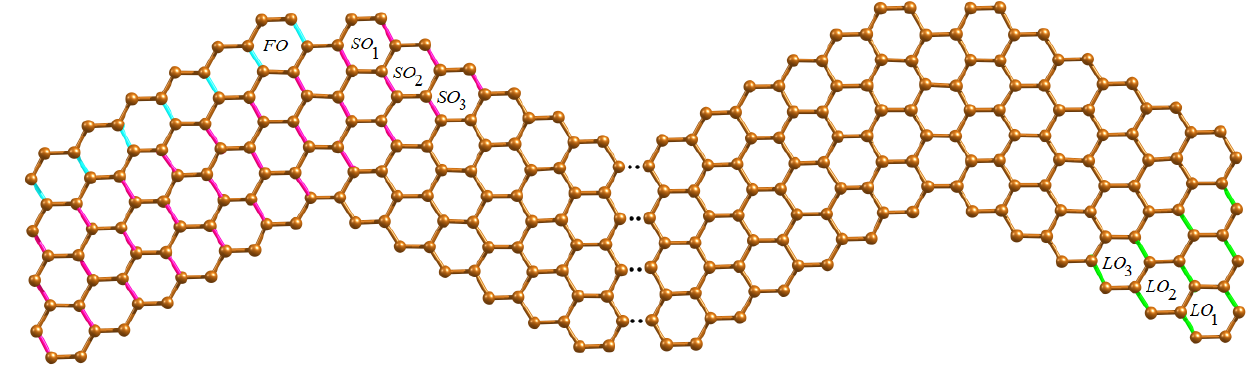
Figure 3. O-type Θ -classes on the initial and final unit of WNR ( 4,6, n ) .